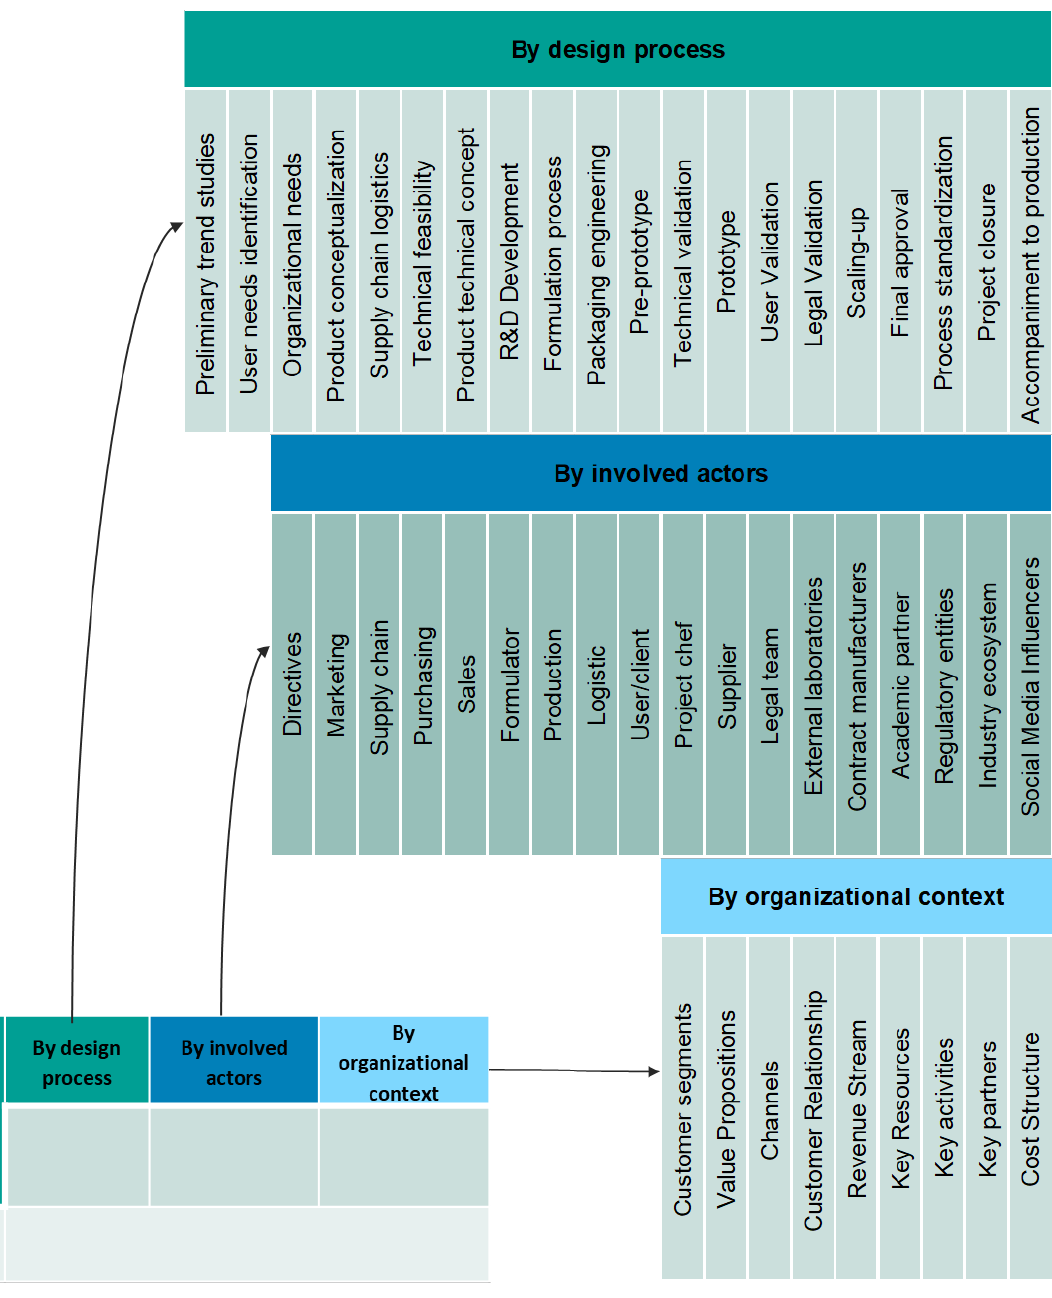
Figure 6. Compilation of the elements of the analysis framework.